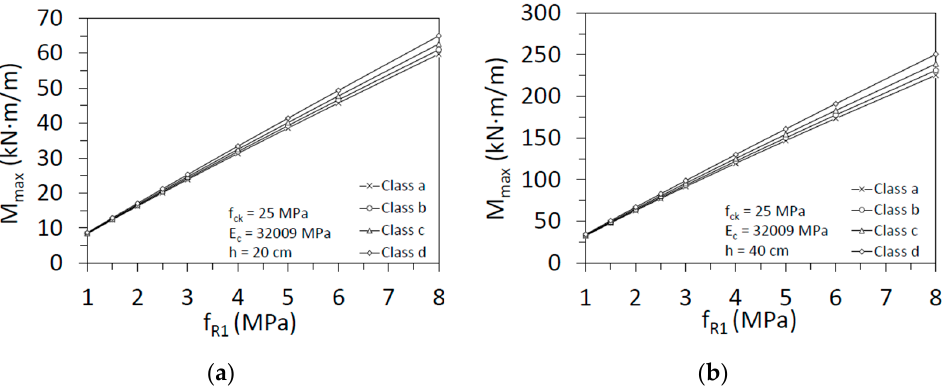
Figure 11. Maximum bending moment versus residual strength f R1 for two section’s depths: ( a ) 20 cm; ( b ) 40 cm.